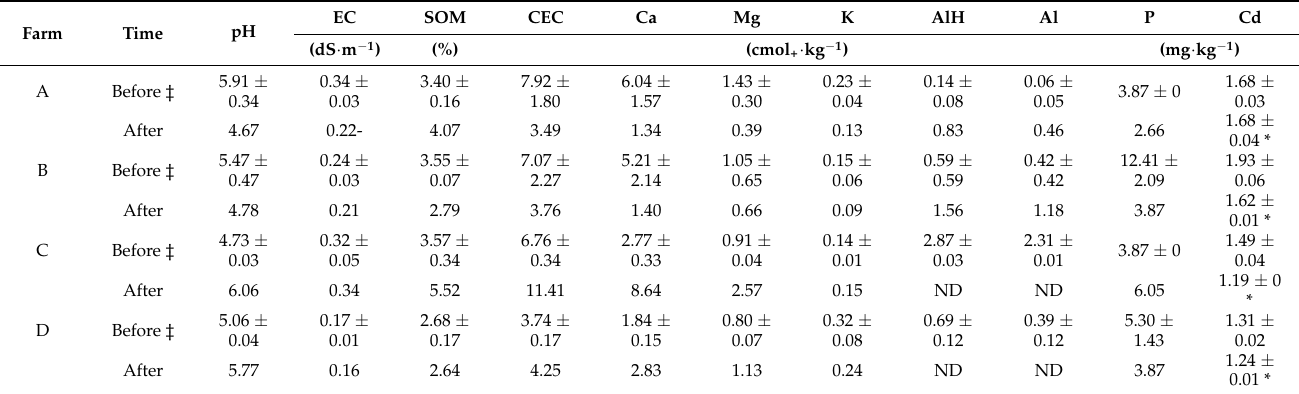
Table 3. Soil properties before and after treatment applications. Abbreviations: EC = electric conductivity, SOM = soil organic matter, CEC = cation exchange capacity and AlH = interchangeable acidity. Standard deviation was computed by n of each farm when replicates were obtained. Number of samples per farm (n): A before: n = 7, after: n = 2; B before: n = 2, after: n = 1; C before: n = 2, after: n = 1; D before: n = 2, after: n =